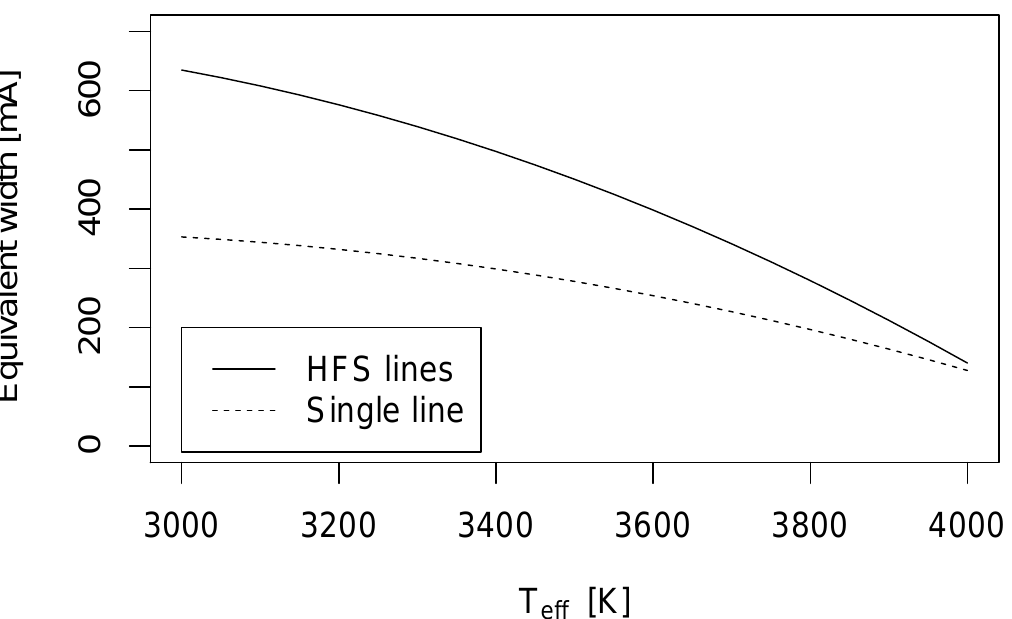
Figure 2. Figure from Thorsbro et al. [6] (their Figure 3). The equivalent width of a Sc I line as a function of temperature depends on whether the Sc I line is considered to be a combination of many small lines due to the hyperfine structure (HFS) or if the line is considered to be a singular atomic level transition. Notice how at high temperature, the two analyses converge, but at cooler temperatures, the HFS of the line enables the spectral line feature to become considerably stronger compared to basing the analysis on a singular atomic level transition. The metallicity and scandium abundance is assumed to be solar, and the surface gravity is assumed to follow isochrone relations with changing temperatures. Non-LTE and 3D effects are not